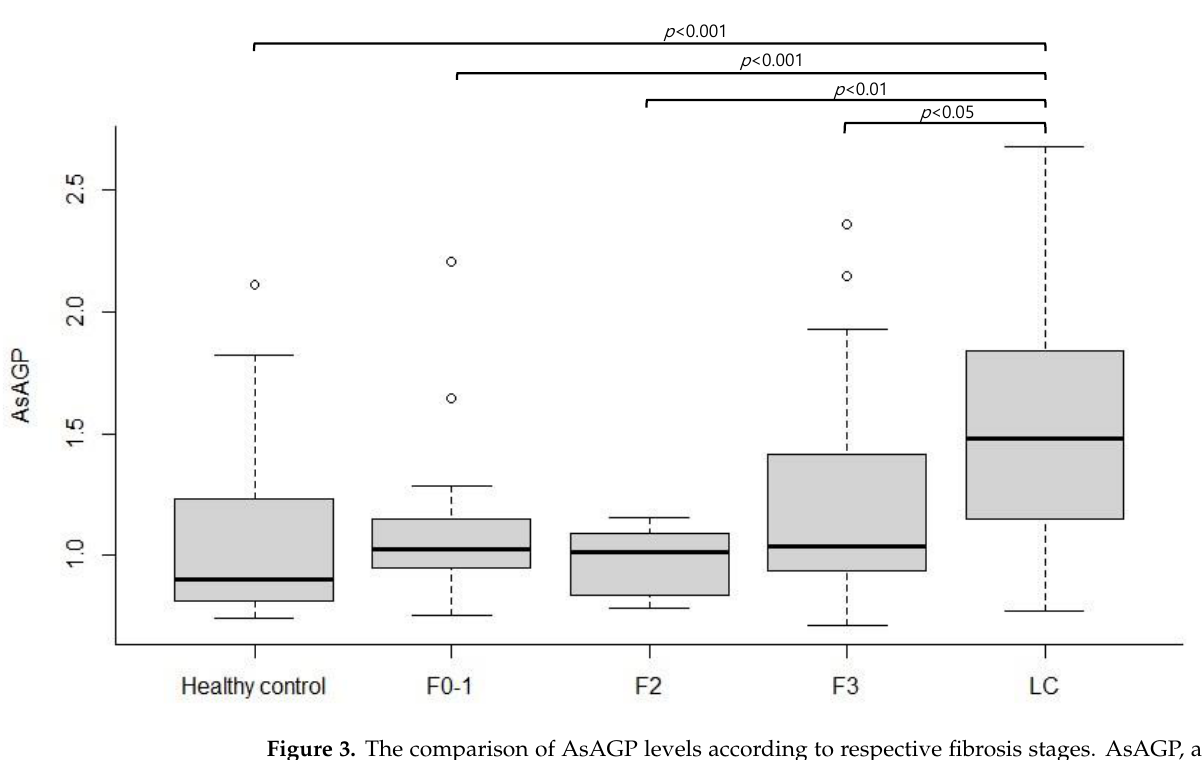
α 1-acid glycoprotein; F, fibrosis stage; LC, liver cirrhosis. Figure 3. The comparison of AsAGP levels according to respective fibrosis stages. AsAGP, asialo α1 -acid glycoprotein; F, fibrosis stage; LC, liver cirrhosis.